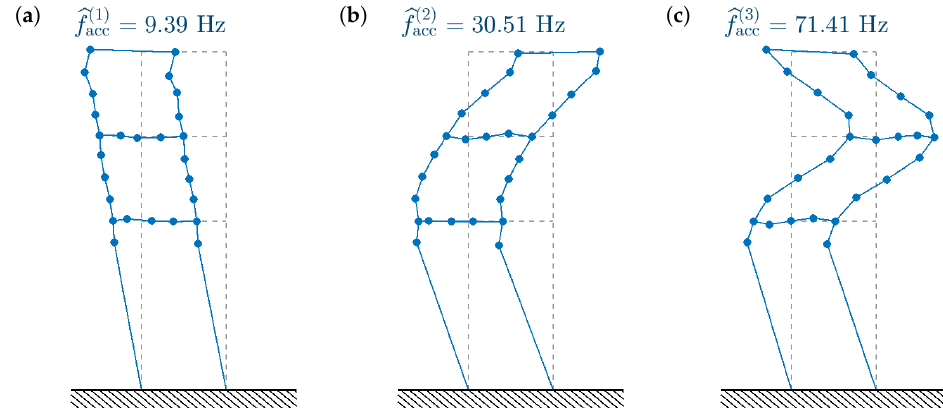
Figure 8. First three vibration modes identified with the aid of the bidirectional accelerometers (dots indicate accelerometer